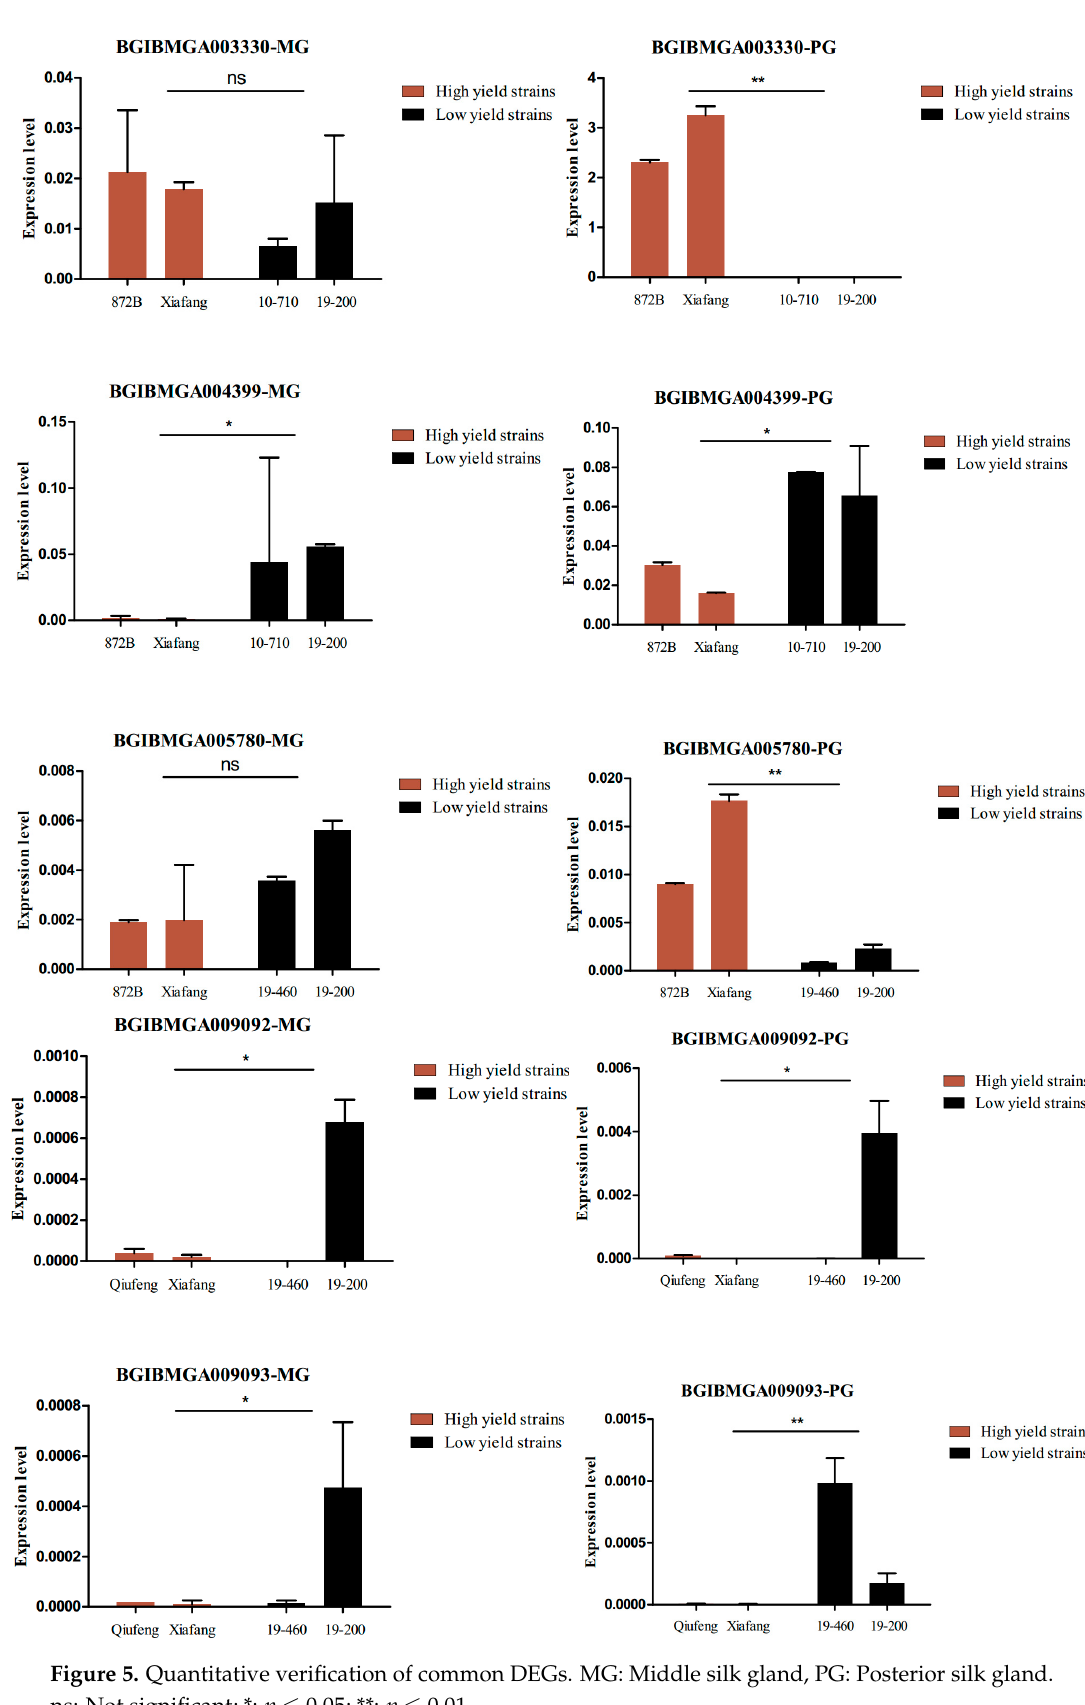
Figure 6. Association analysis of partial gene expression levels with cocoon shell weight (CSW). In the figure, only the association analysis diagram of the associated significant gene is listed, ns: Not significant; *: p ≤ 0.05; **: p ≤ 0.01; ***: p ≤ 0.001. 2.5. PCA of Wild Silkworm, Local Strains, and Practical Strains Cocoon quality traits undergo two stages of selection, namely, the domestication process from wild silkworm strains to local strains, and the breeding process from local species to practical species. PCA was employed to detect differences in gene expression patterns among various strains by analyzing similarities in major strain components. Thus, differences in selection for silkworm cocoon